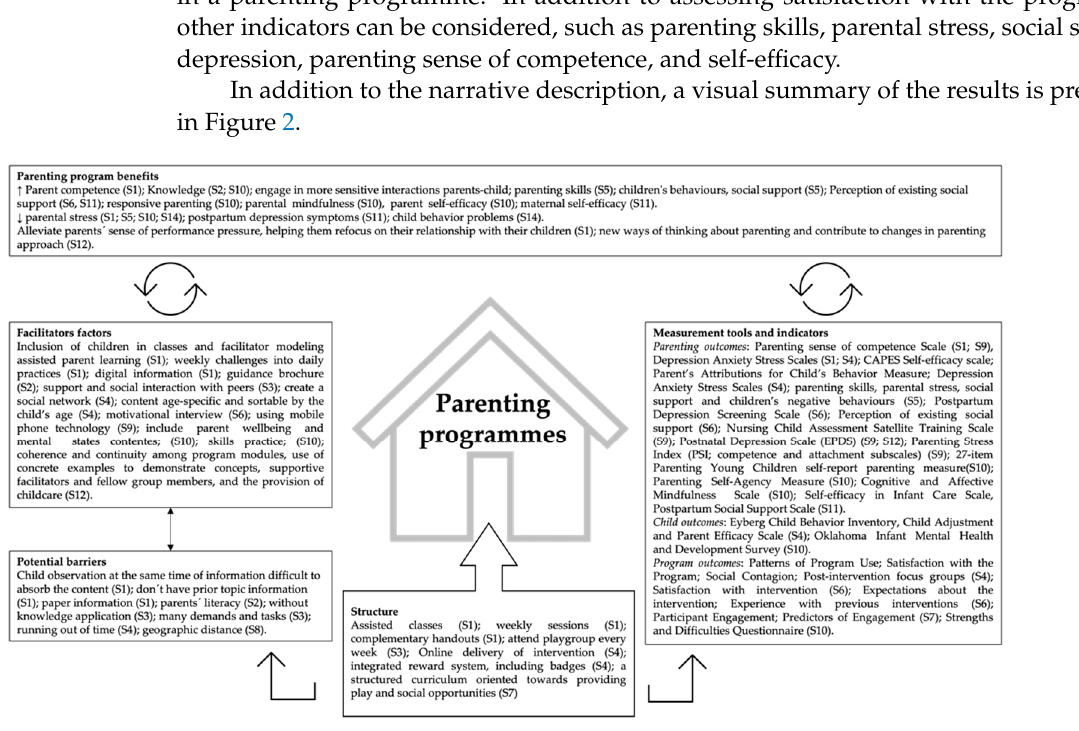
Figure 2. Key findings: benefits, structure, facilitator factors, potential barriers, measurement tools, and indicators of Parenting Programmes .